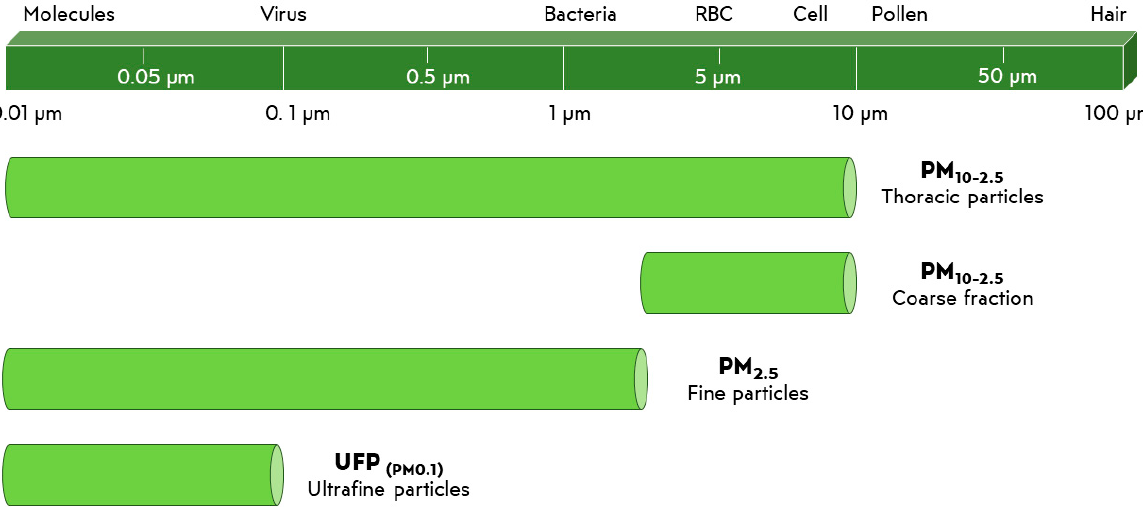
Figure 2. Characterization of particulate matter (PM) based on size. RBC = Red blood